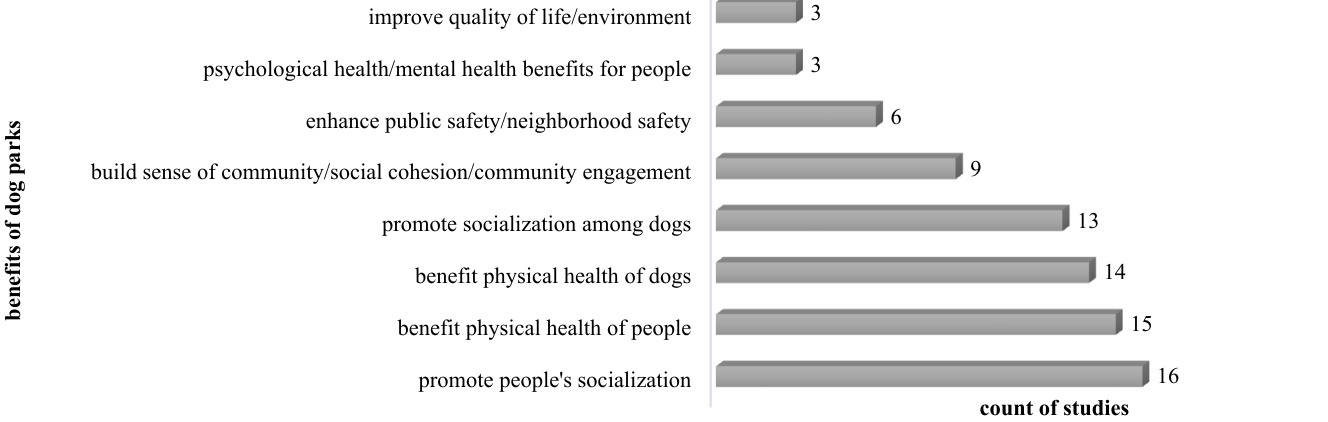
Figure 4. Count of studies identifying the benefits of dog parks.